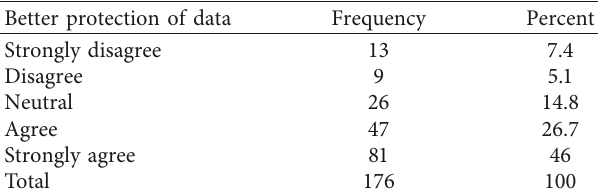
Table 1: Better protection of